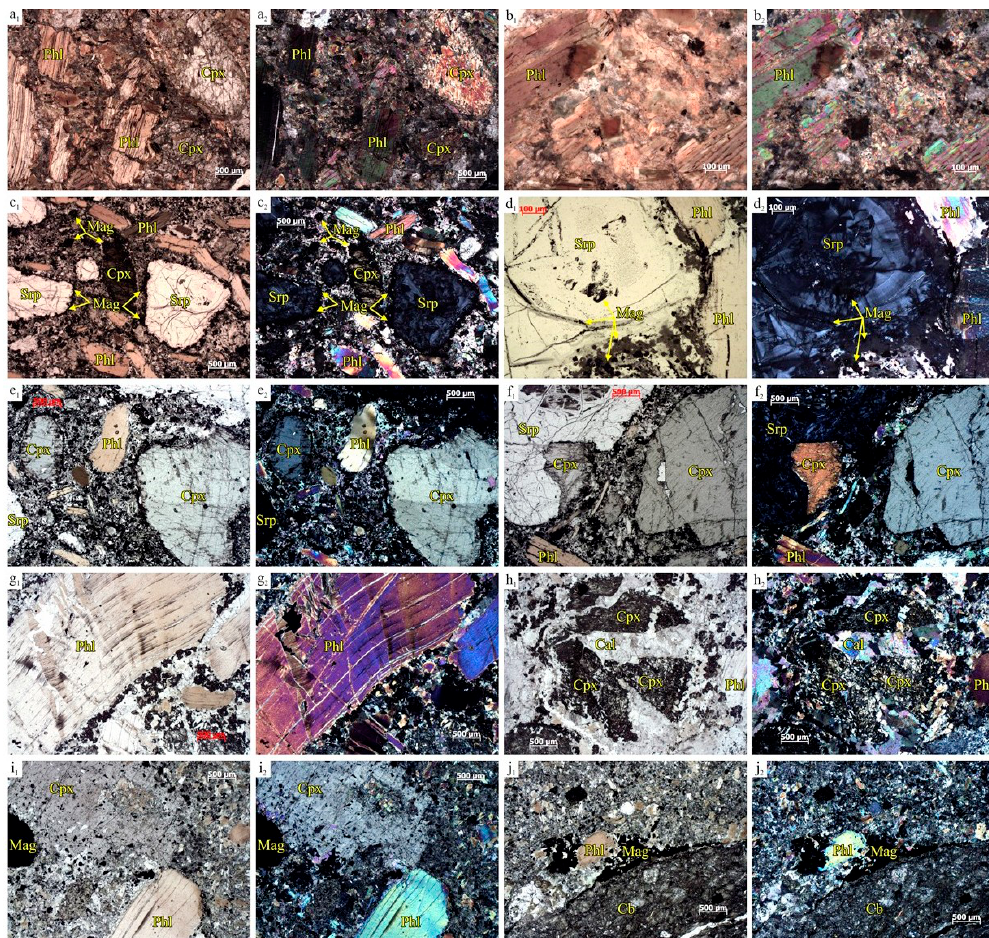
Figure 6. Photos of the aillikites in thin sections ( 1 —parallel and 2 —crossed nicols) of samples BZ726 ( a , b ), 799-1 ( c – f ), BZ732 ( g , h ), BZ742 ( i , j ). ( a ) The aillikite has a porphyritic, lamprophyre structure. The pyroxene grains (Cpx) are deformed, with wavy extinction of phlogopite (Phl) grains, among the fine-grained serpentine-chlorite-carbonate-phlogopite groundmass with a thin rash of magnetite. ( b ) Phlogopite